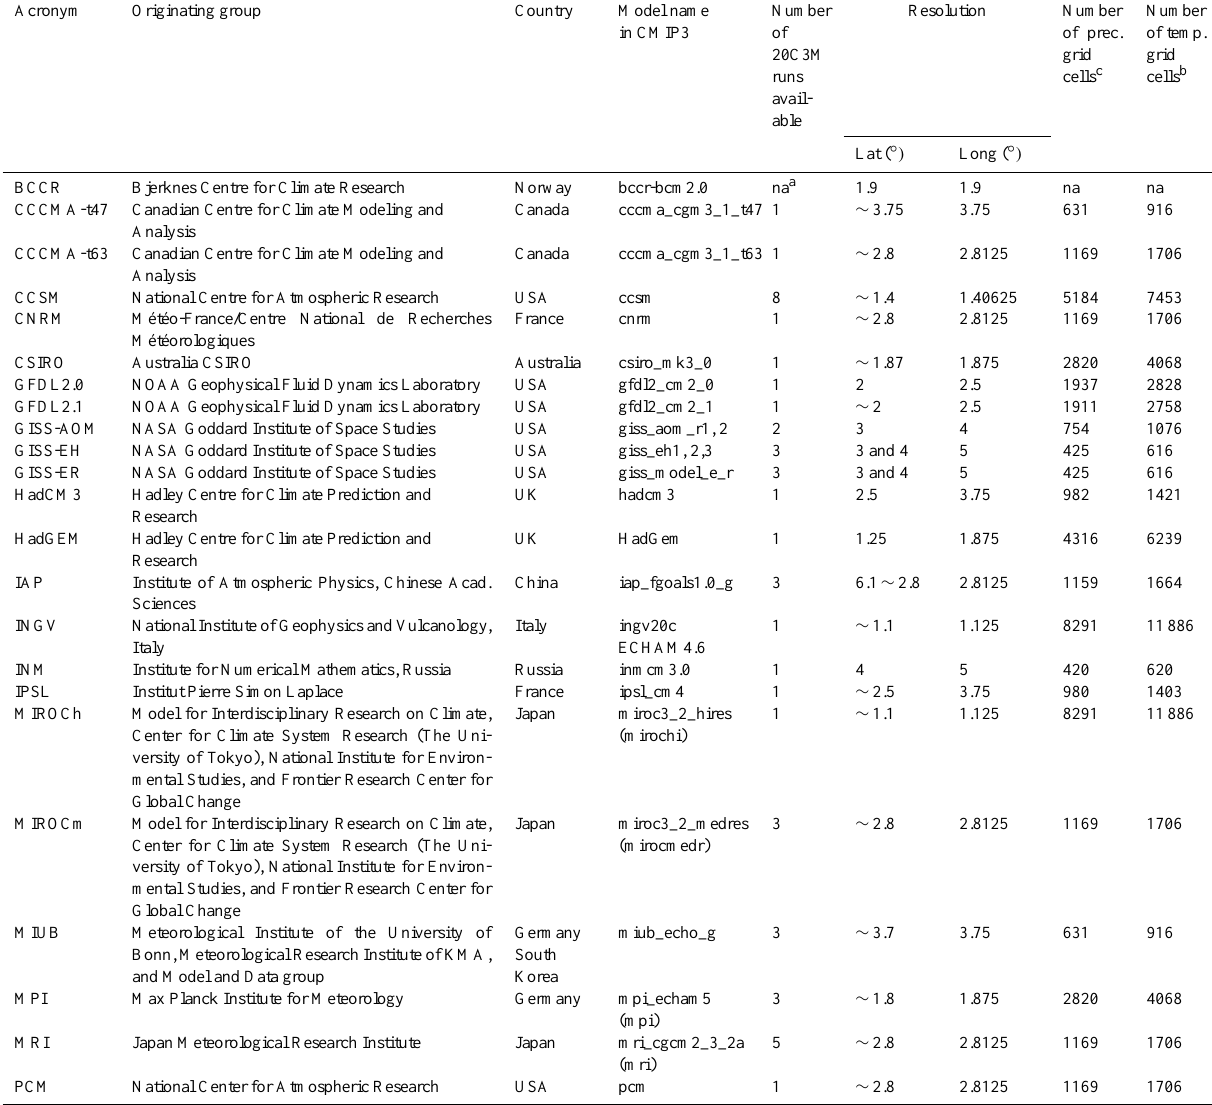
Table 1. Details of 23 GCMs considered in this